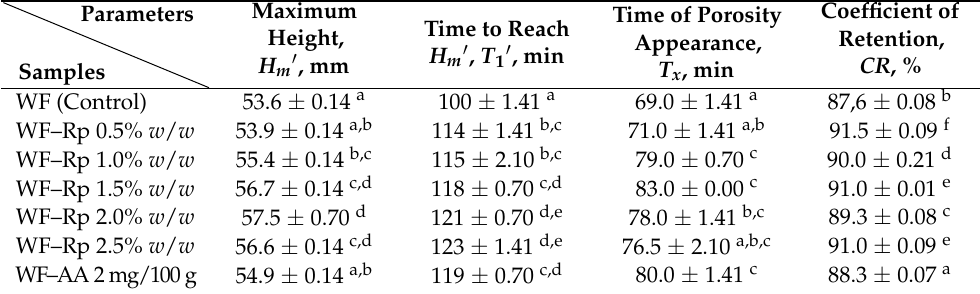
Table 3. Rheofermentographic parameters from the gas formation and retention curve.